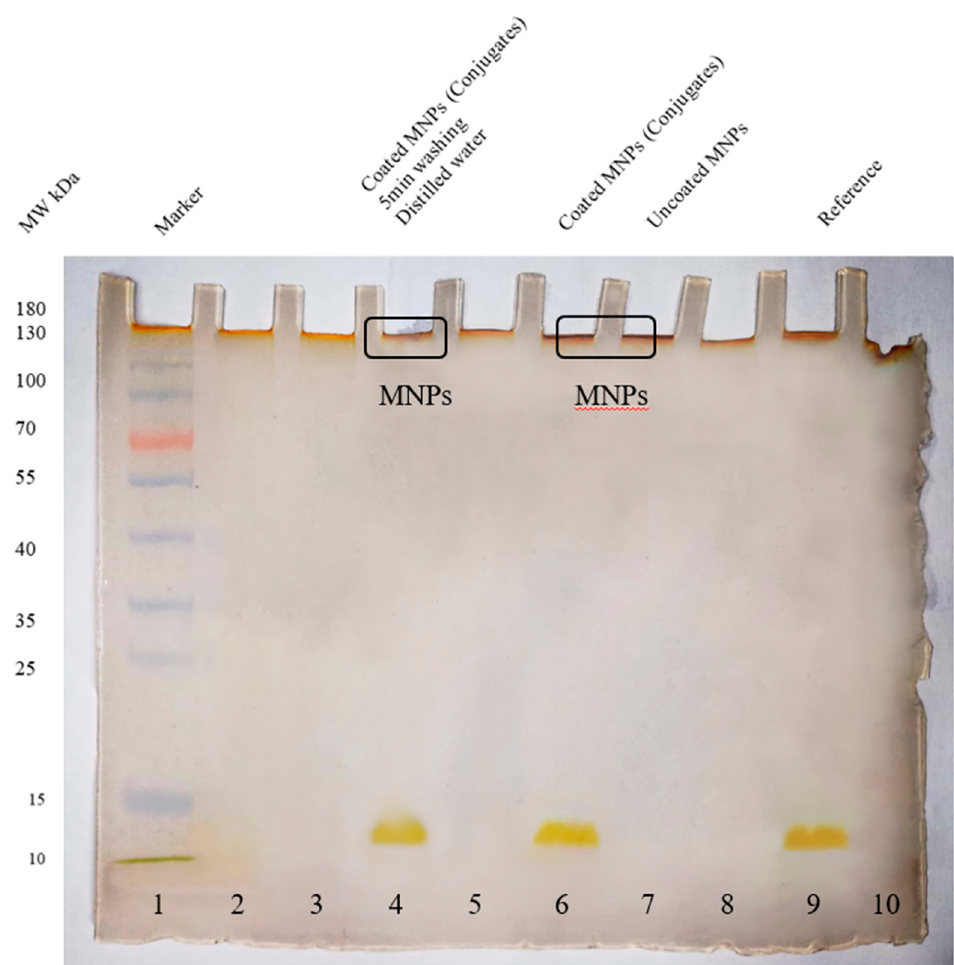
Figure A11. Color image of SDS PAGE gel (uncropped).